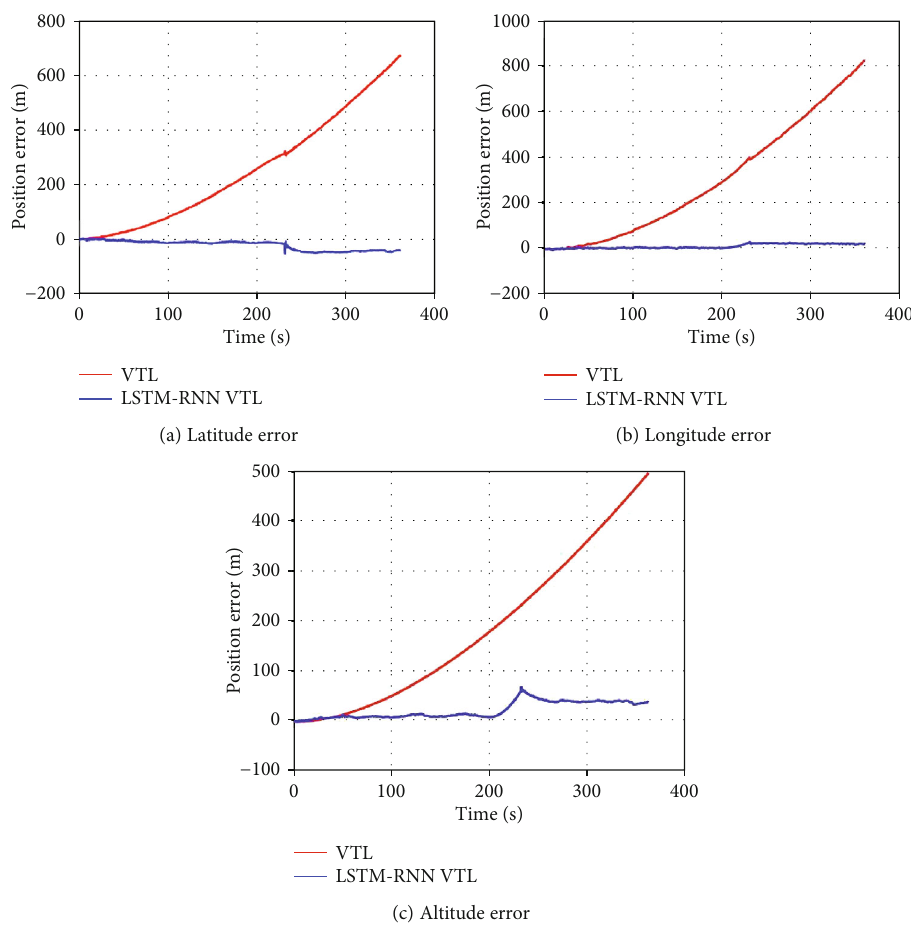
Figure 9: Position errors (two available